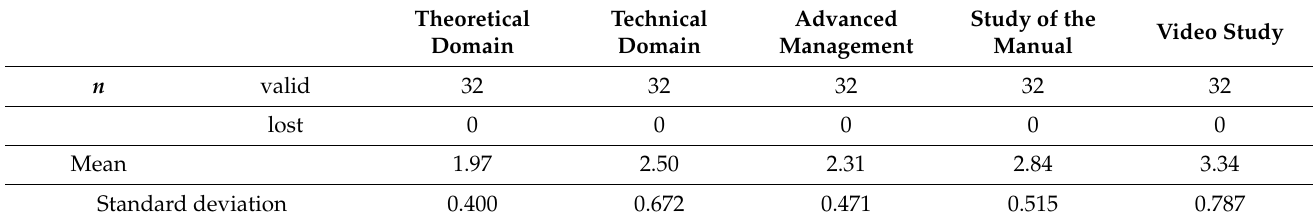
Table 4. Perception of knowledge/learning of students (according to teachers’